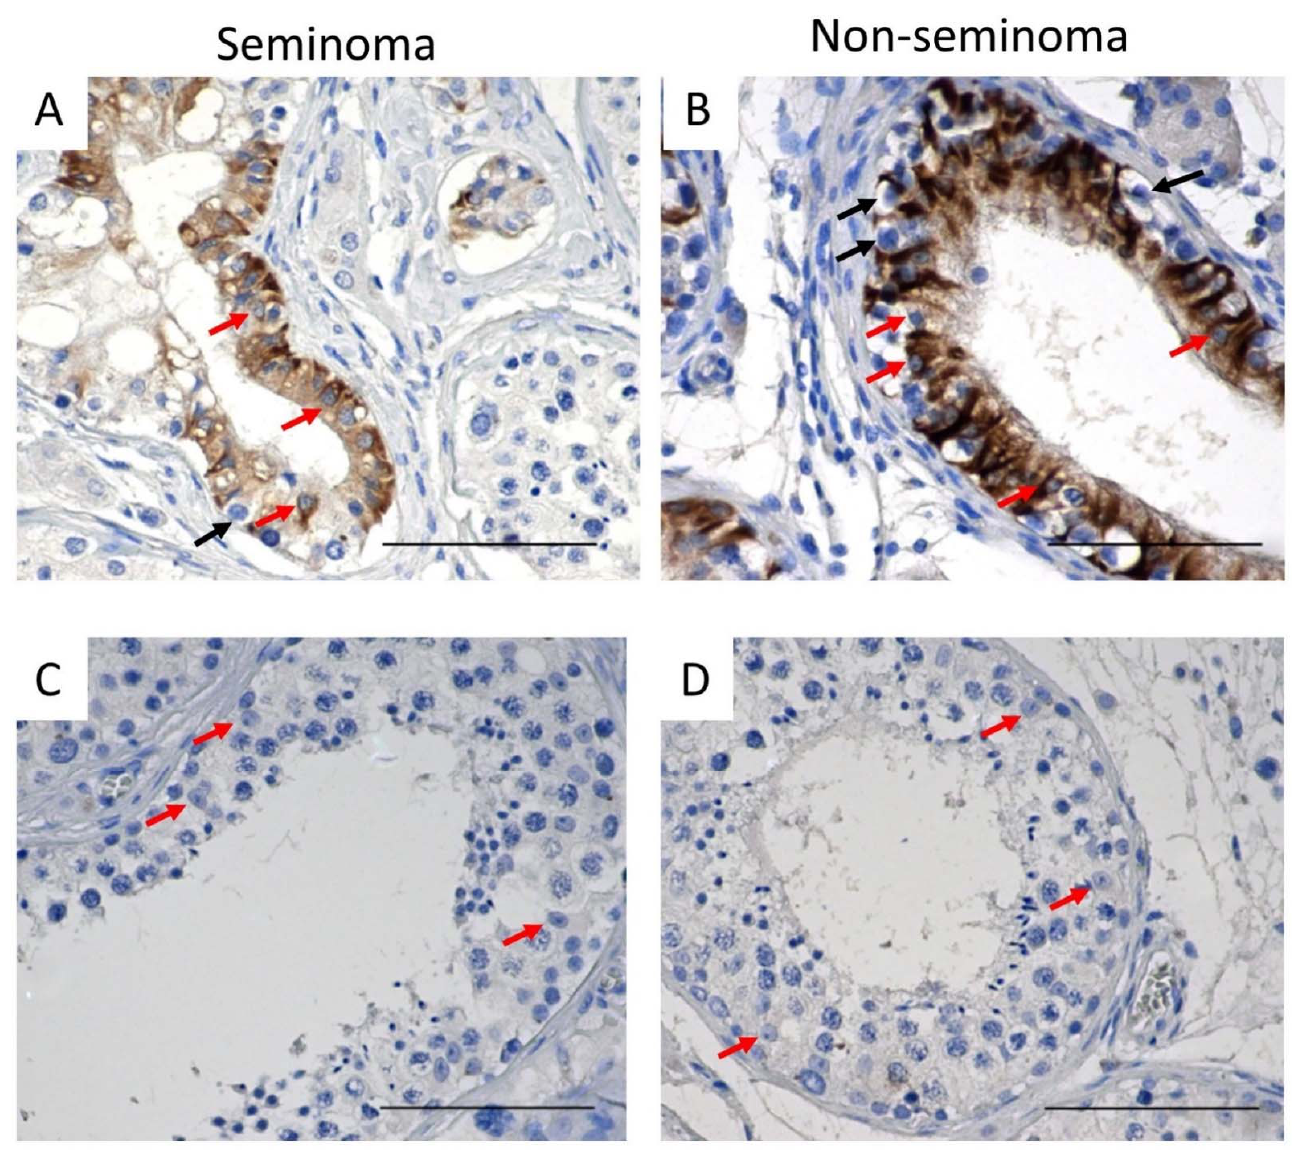
Figure 5. Cytokeratin expression in Sertoli cells of ( A , B ) GCNIS-containing tubules and ( C , D ) tubules with active spermatogenesis on tissue from ( A , C ) seminoma and ( B , D ) non-seminoma patients. Scalebars represent 100 μ M, red arrows: Sertoli cells, black arrows: GCNIS cells. Cytokeratin expression in Sertoli cells from GCNIS-containing tubules was noted to be heterogeneous with cytokeratin + and cytokeratin − Sertoli cells observed. In addition, some of the GCNIS-containing tubules had no cytokeratin-positive Sertoli cells (Figure 5). There was no difference in the proportion of cytokeratin + and cytokeratin − Sertoli between GCNIS ‐ containing tubules from seminoma and non ‐ seminoma samples (Figure 6C).